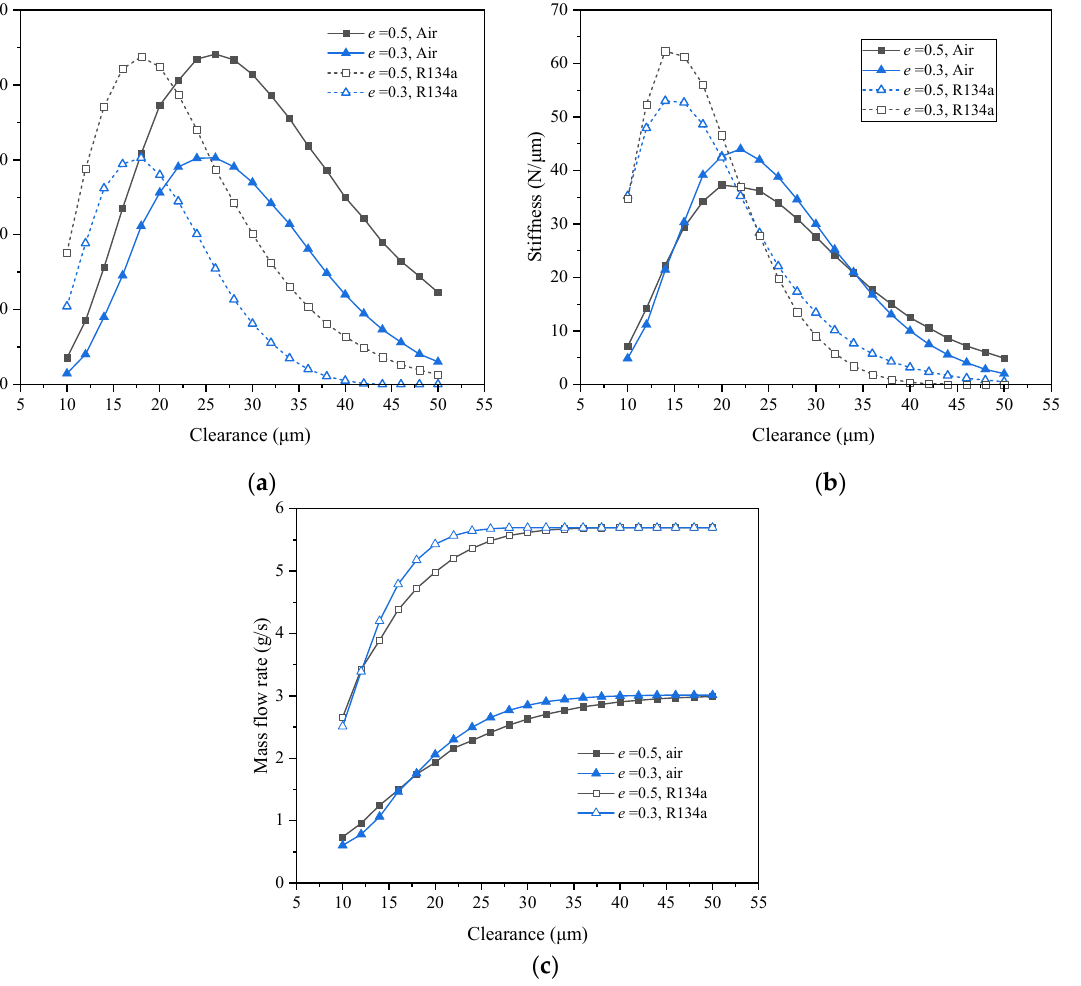
Figure 8. Effect of average clearance under different eccentricity ratios ( h 0 = 20 μ m, d = 0.3 mm) ( a ) on load capacity ( b ) on stiffness ( c ) on mass flow rate.